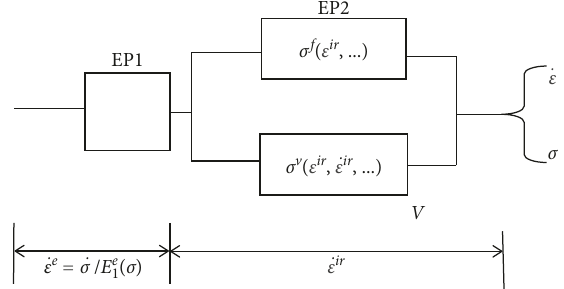
Figure 1: General nonlinear three-component model (Benedetto